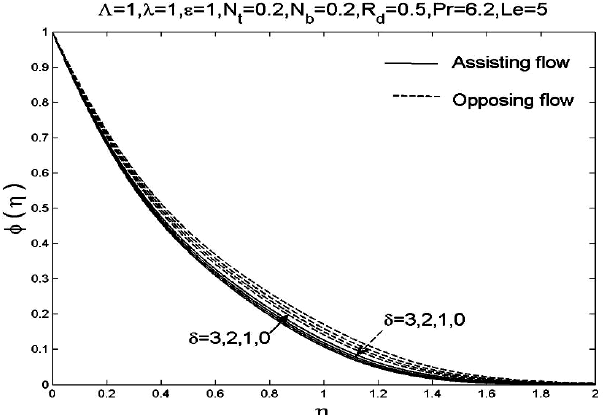
Fig. 22. The effect of the solutal buoyancy parameter δ on the concentration profiles ( ) φη .